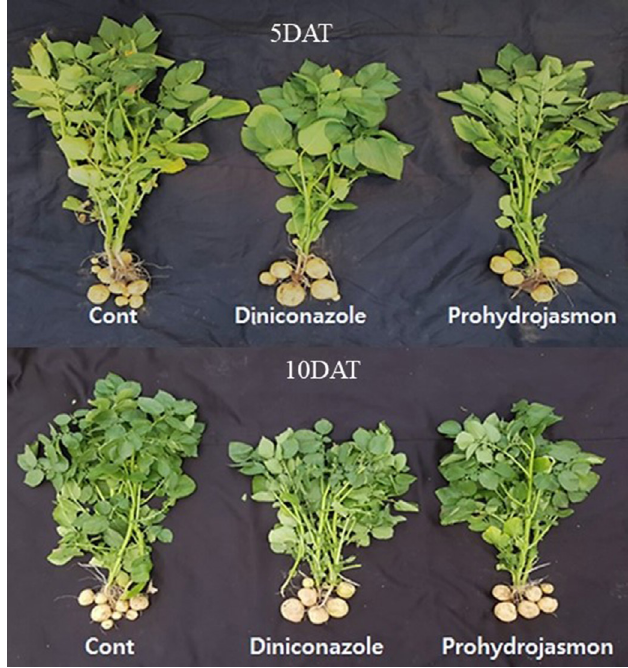
Supplementary Fig. 1: phenotypical visualization of potato plants height after 5 and 10 days of Din and PDJ treatments.